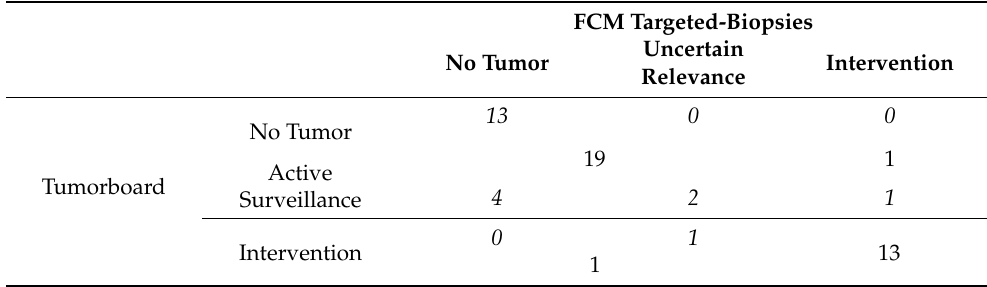
Table 3. Comparison of intraoperative estimations based on FCM analyses with final tumor board